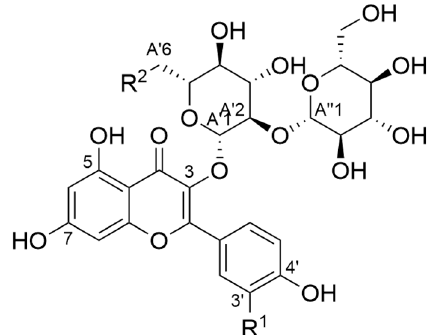
Figure 9. Molecular structures of flavonol glycosides isolated from Hydrangea macrophylla ssp. serrata.